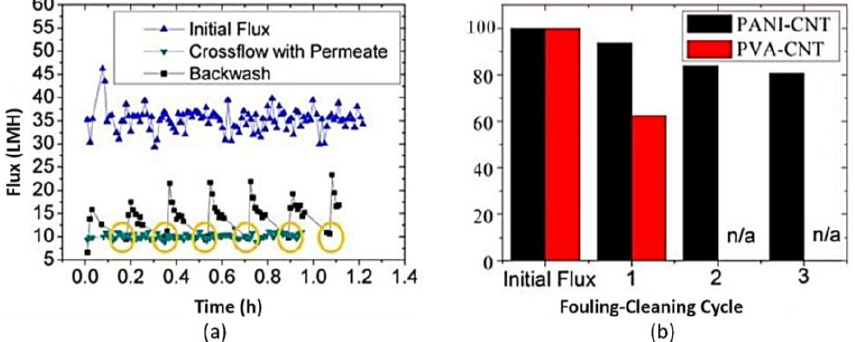
Figure 11. ( a ) Flux and ( b ) fouling behavior in PANI/CNT-COOH membranes. Reprinted from [122], with permission from American Chemical Society.